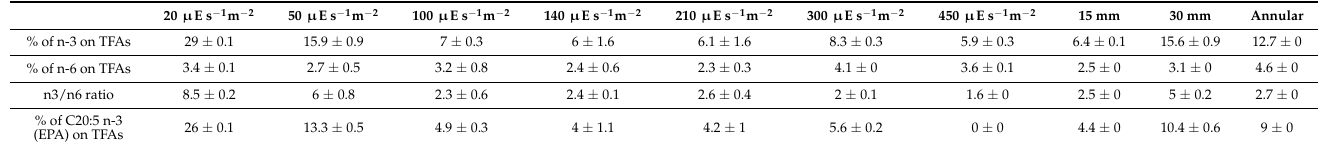
Table 3. Specific fatty acid classes in total fatty acids (TFAs) of the biomass obtained at the end of the batch cultivations grown under different photon flux densities and in reactors with different configurations with I 0 = 210 µ E s − 1 m − 2 . n-3 and n-6 represent classes of fatty acids with the first unsaturation at the carbon 3 or 6. EPA: eicosapentaenoic